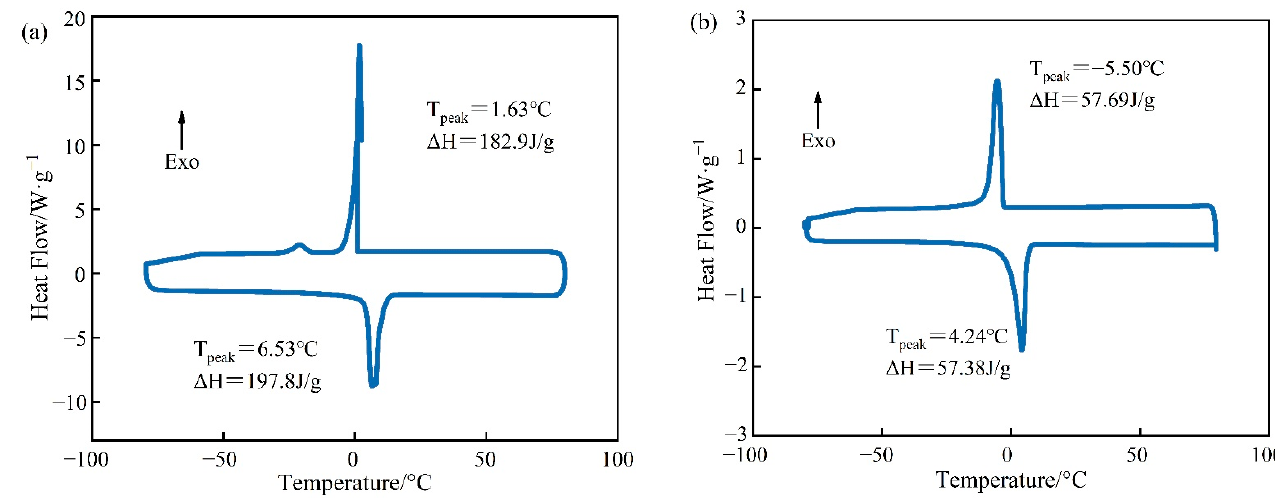
Figure 6. DSC curves of PCM for ( a ) pure Tet and ( b ) Tet/SiO 2 composite shaped